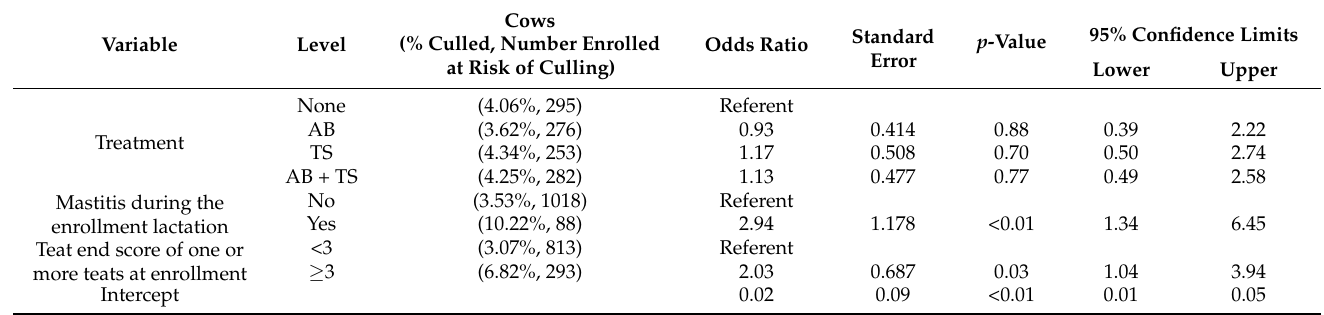
Table 4. Generalized linear mixed model with logit link predicting culling during dry period among different treatment groups (AB, TS, AB + TS, None) 1 on California dairies ( n = 8 herds).